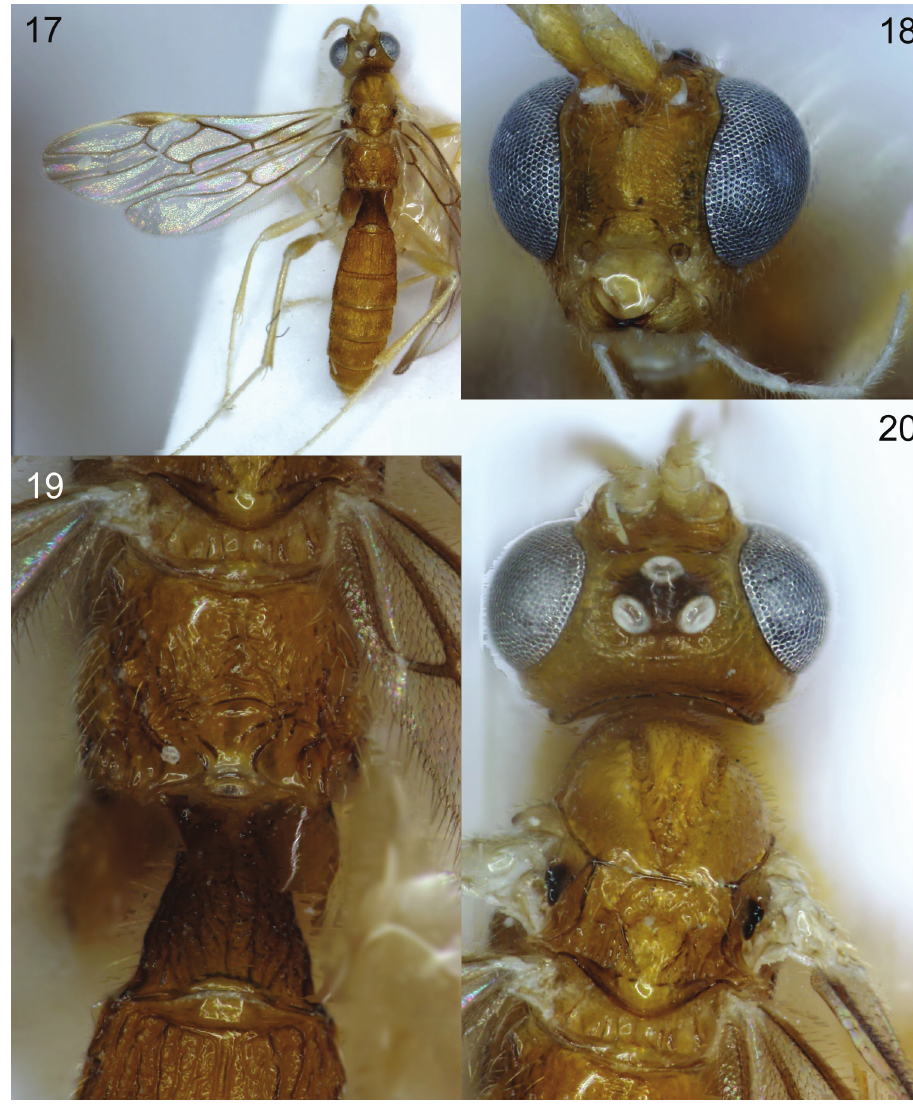
dorsal view 18 face, showing slender 3 rd segment of maxillary palp 19 propodeum 20 head and anterior mesosoma, dorsal